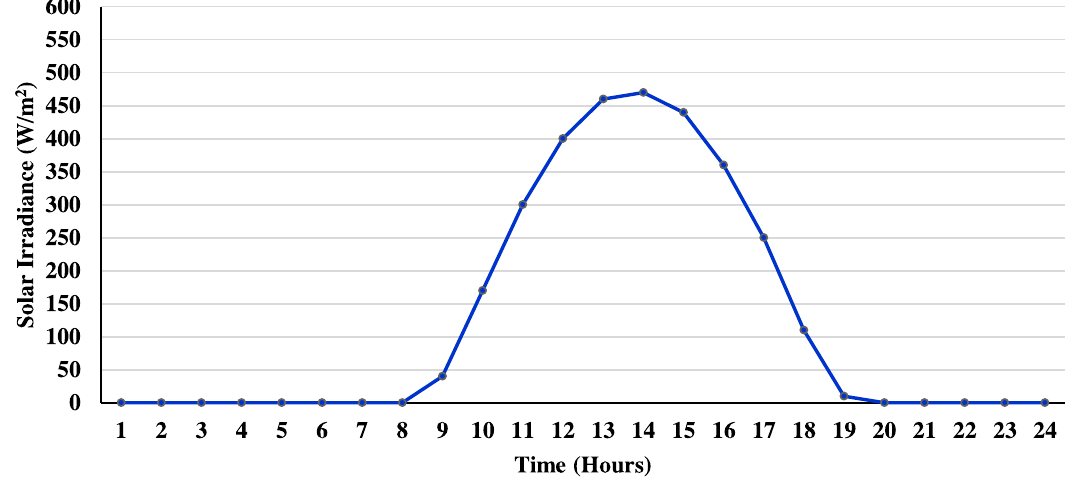
Fig. 1. Daily solar energy pro fi le in